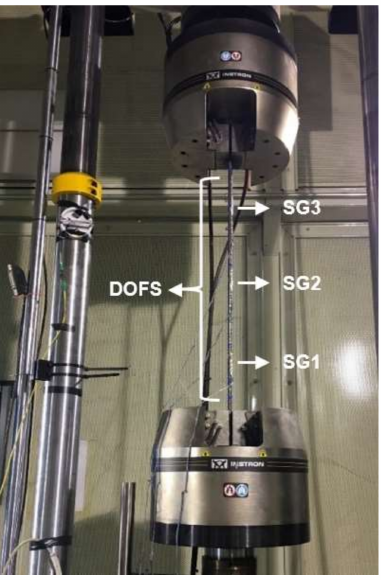
Figure 4. General scheme of the instrumented rebar for the tensile test with the DOFS and the strain gauges.